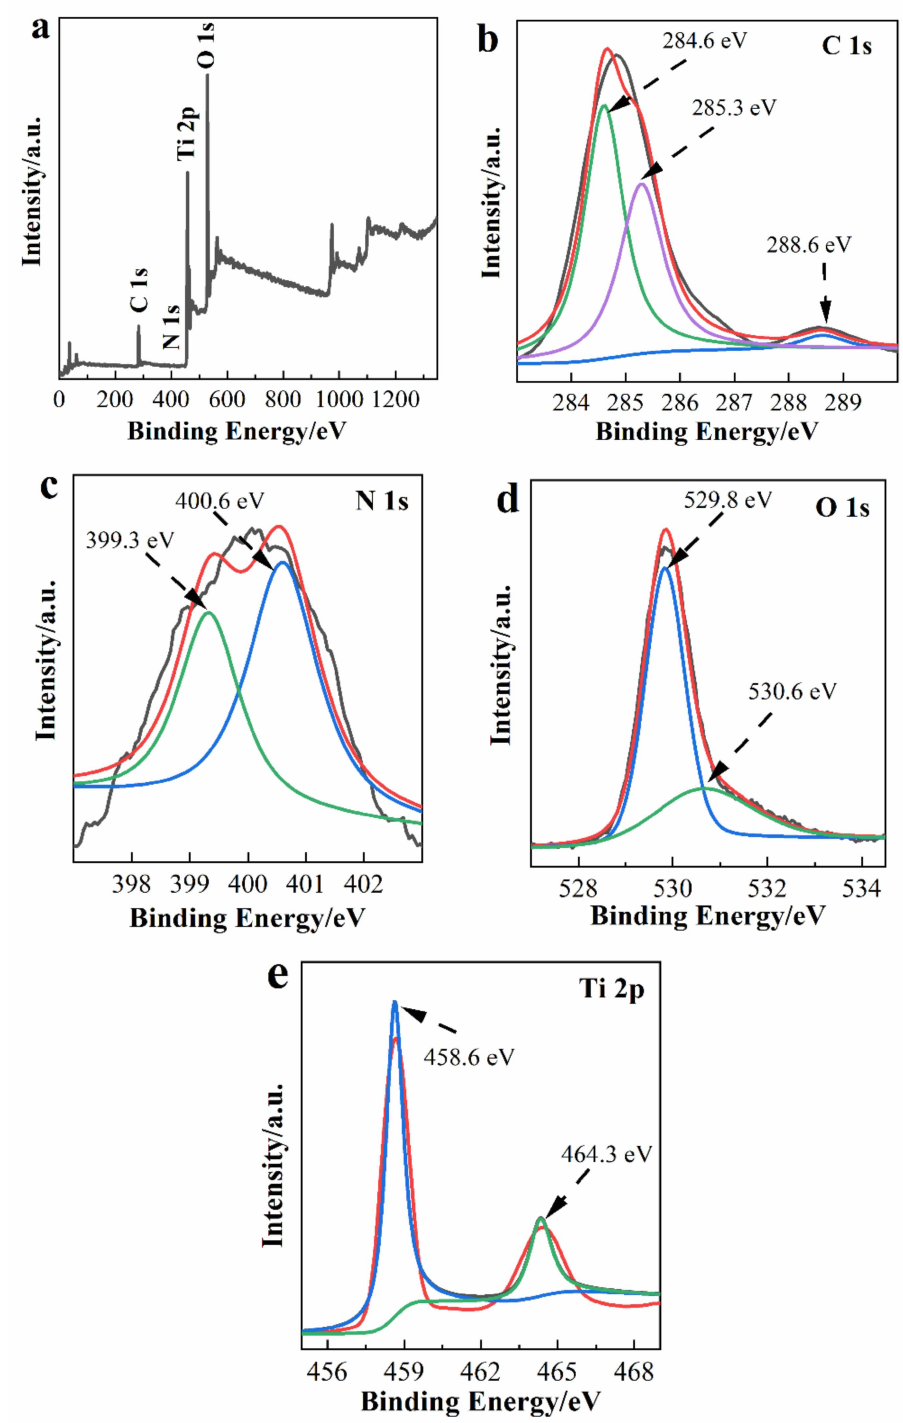
Figure 7. XPS of survey ( a ), C1s ( b ), N1s ( c ), O1s ( d ) and Ti2p ( e ) scans of TCN-T 550